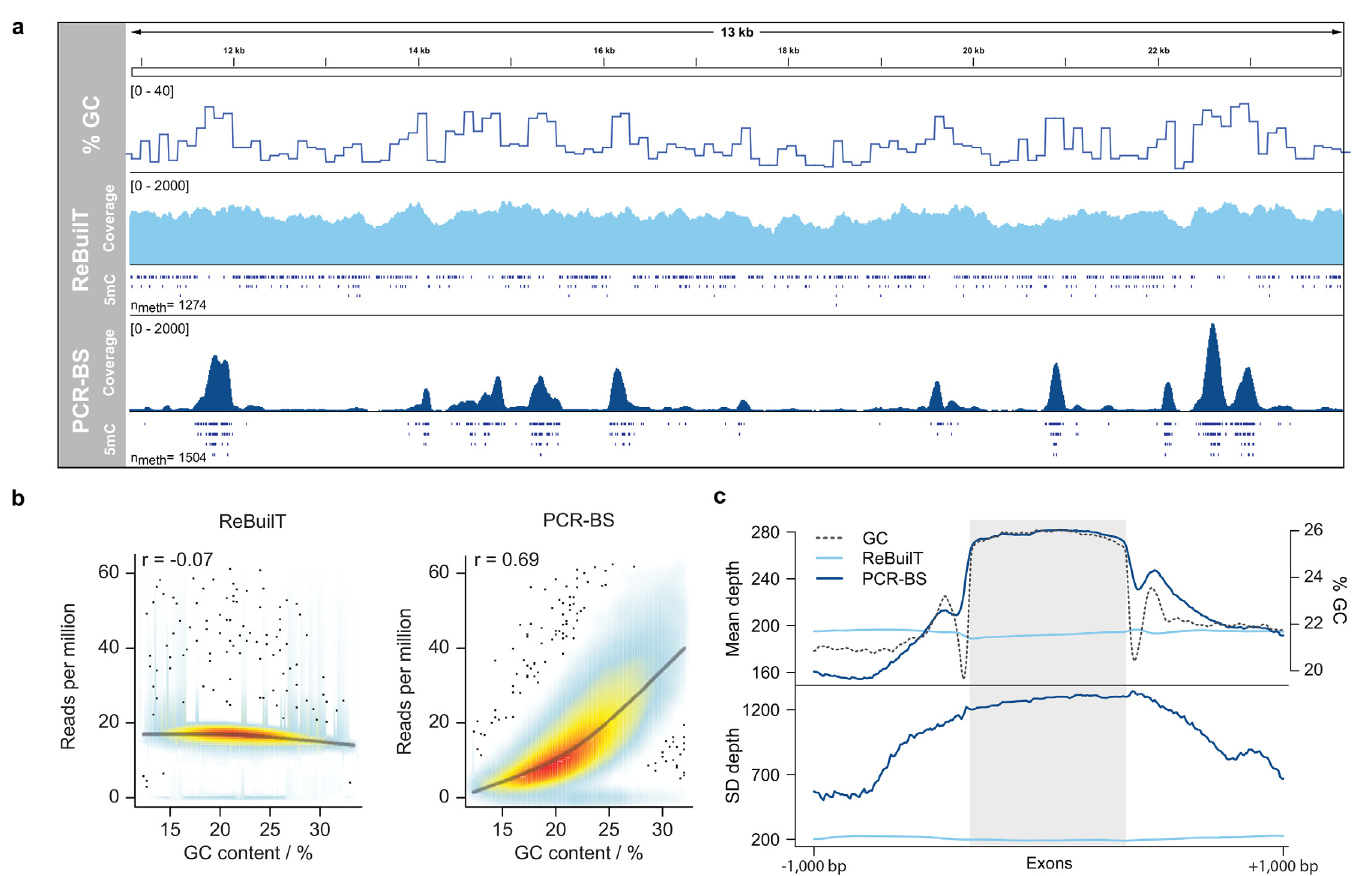
Fig 3. Effect of GC content on uniformity of coverage. (a) Genome browser view showing the coverage obtained across a region from P. berghei for both methods. While near constant for ReBuilT, distinct read pile-ups in PCR-BS that appear to track GC content. (b) The GC content was calculated in 300 bp windows and plotted against the normalized informative read count. PCR amplification induces a strong preference for more balanced base compositions. (c) In P. berghei the GC content has a distinct profile across exons (dashed line). ReBuilT coverage is unaffected across this genomic feature, while PCR-BS tracks the GC percentage